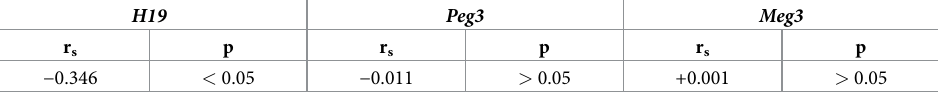
Table 3. Spearman correlation analysis for average methylation levels of imprinted genes.